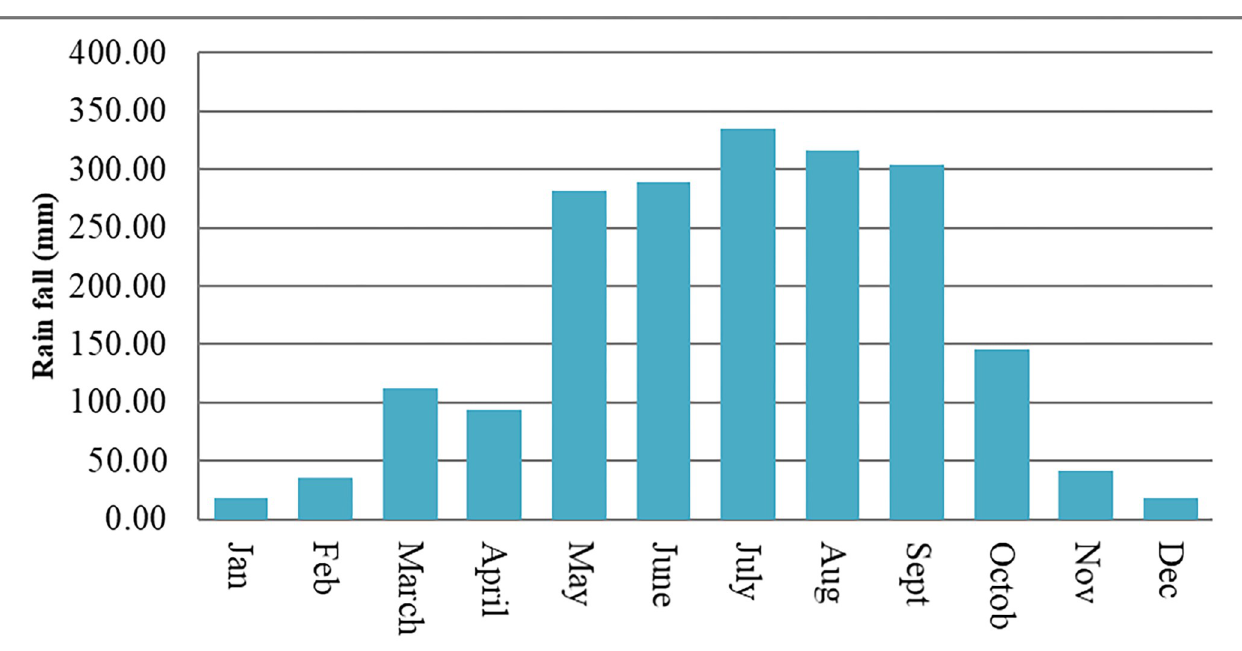
Fig 2. Monthly total rainfall (mm) of Mettu during crop growth period in